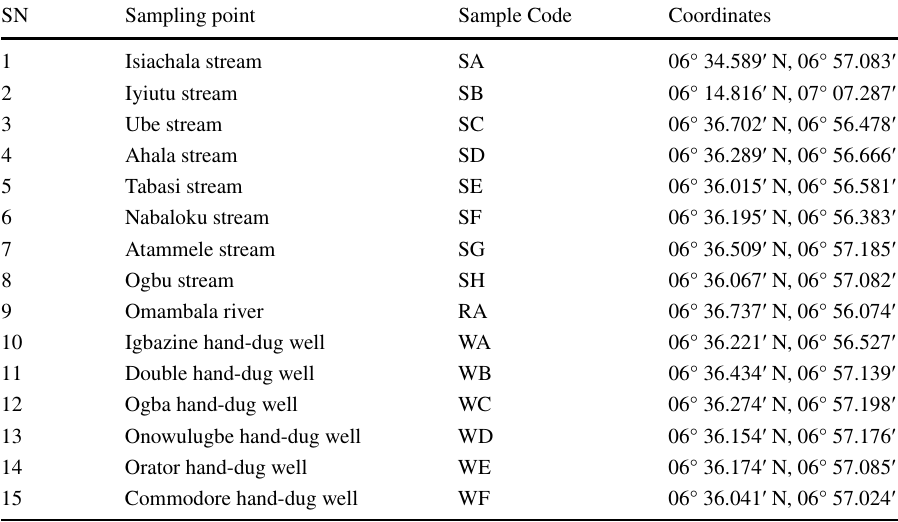
Table 1 Selected points for water sampling in Ifite Ogwari, Anambra